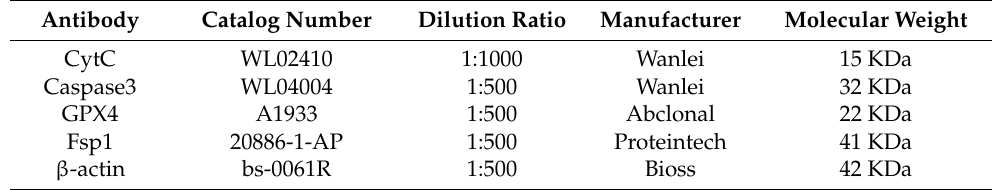
Table 1. Western Blot Antibody